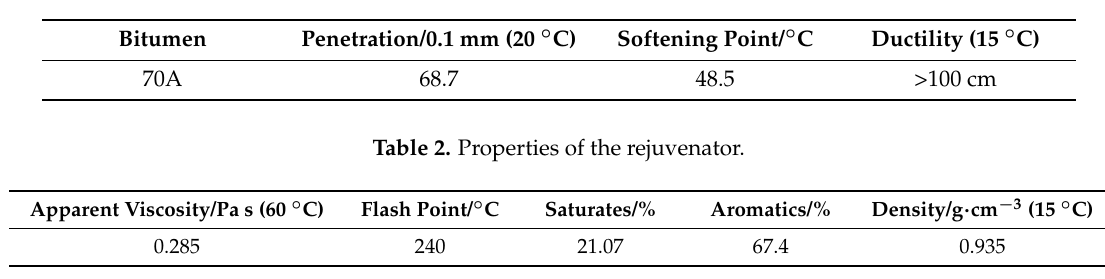
Table 1. Properties of the 70A bitumen binder.